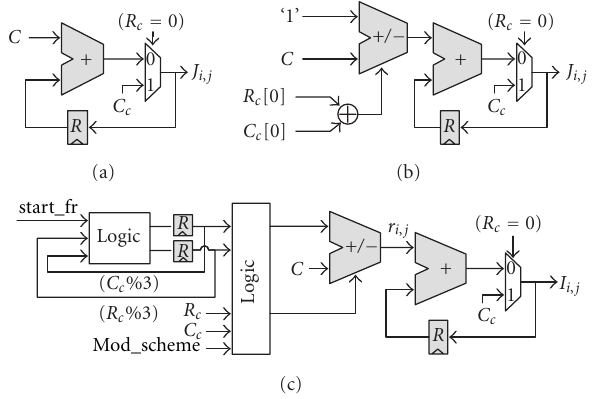
Figure 7: Interleaver address generation for (a) BPSK - QPSK, (b) 16-QAM, and (c) combined for all modulation schemes.